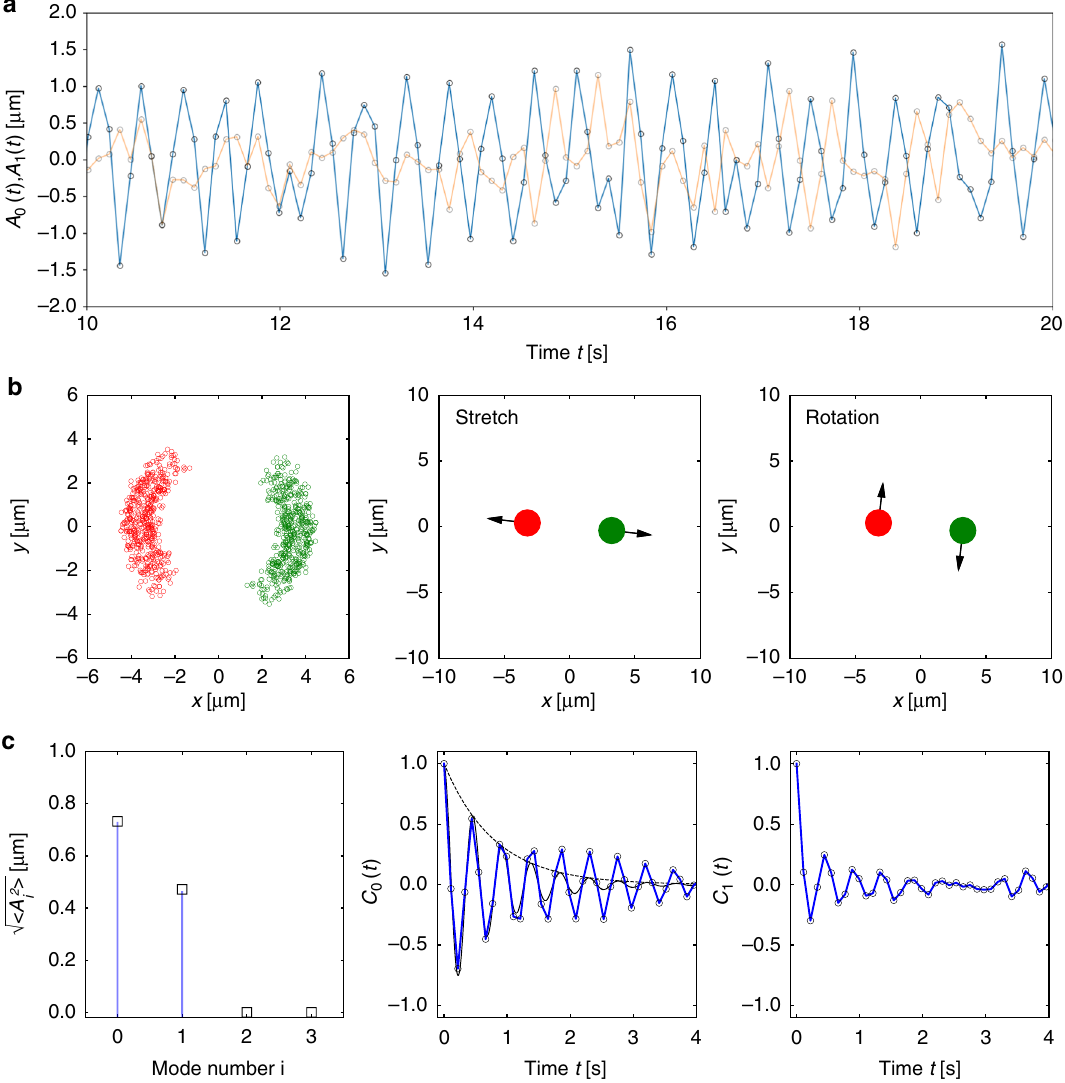
Fig. 4 Dynamics of a self-organized active particle dimer. a Change of the dimer bond length parallel (blue) and perpendicular (orange) to the connecting line of the two particles. The dimer bond length is oscillating with a triangular shaped elongation with a period of T = 0.44 s. The period corresponds to four times the feedback delay time δ t = 0.11 s. b Left: trajectory points of the two bound particles in the center of mass (COM) frame. Middle and right: principle components of the particle displacements in the center of mass frame as obtained from a principle component analysis (PCA). c Left: principle component amplitudes as calculated for the two modes in b . Middle and right: autocorrelation functions for the displacements of the particles in the center of mass frame of the two eigenvectors obtained from the PCA. The two modes reveal a damped oscillation due to the Brownian motion of the active particles. The middle graph shows in addition the theoretical prediction for the oscillation (black solid line) and the exponential decay due to the dephasing (black dashed